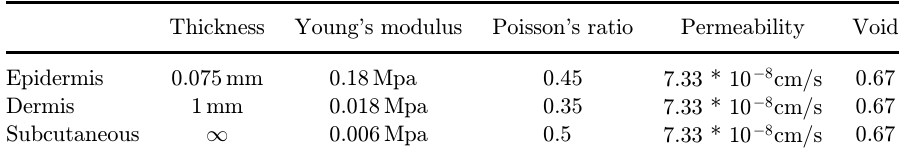
Table 2. Material properties of skin in ABAQUS